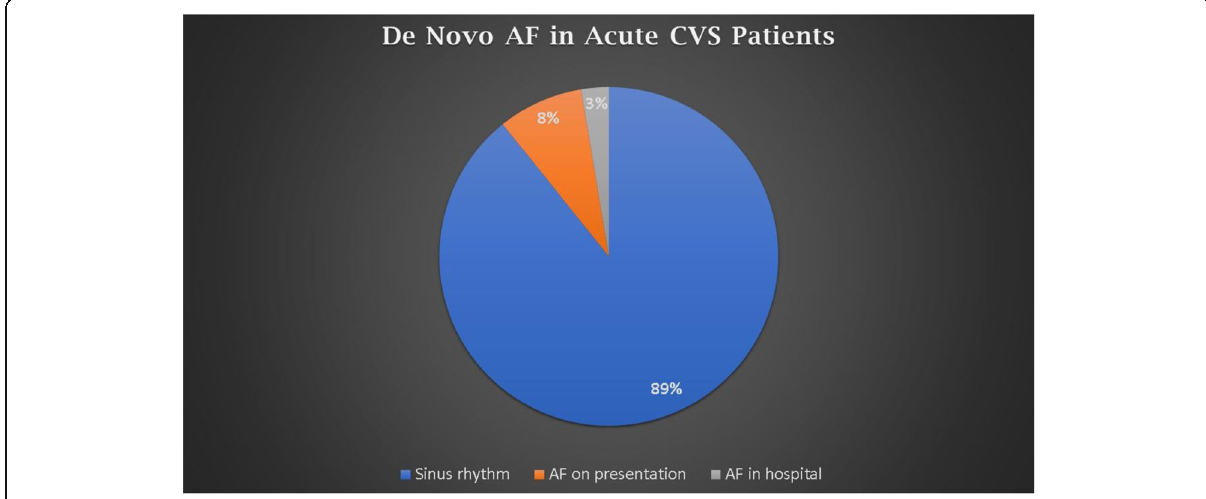
Fig. 1 Prevalence of de novo AF in acute ischemic CVS